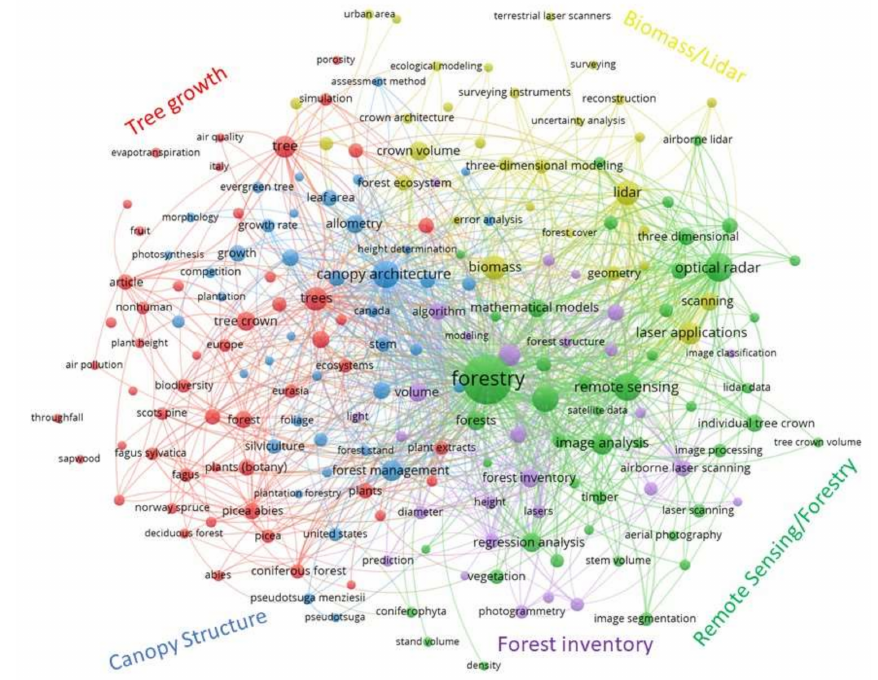
Figure 1. Research trend clusters related to tree crown volume